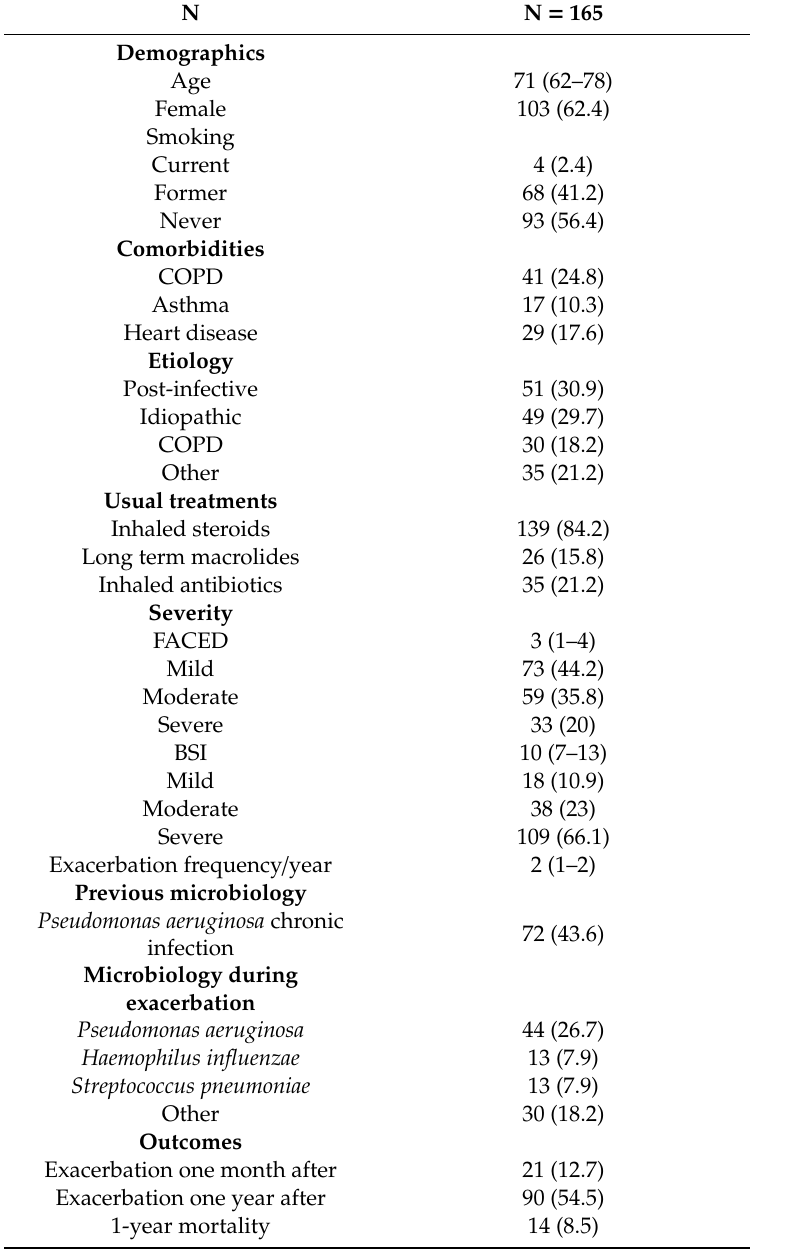
Table 1. Patients characteristics in the whole cohort of